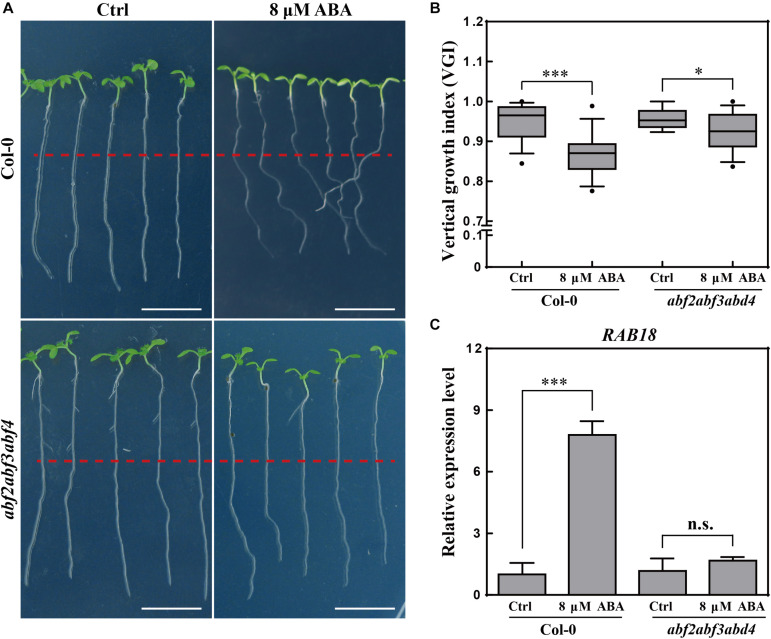
Root VGI of Col-0 and abf2abf3abf4 in response to ABA treatment. (A) Representative images of Col-0 and abf2abf3abf4 seedlings for control and following ABA treatment. 5-day-old seedlings were treated with 8 μM ABA; the photographs were taken 3-day after transfer. White bar represents a scaling bar of 1 cm. n > 30. (B) Root VGI of Col-0 and abf2abf3abf4 seedlings for control and following ABA treatment. Each bar represents the mean of 30 independent measurements ± SE. (C) Relative expression level of RAB18 in roots of Col-0 and abf2abf3abf4 with and without ABA treatment. Each bar represents the mean of 3 biological samples and 3 technical replicates ± SE. * and *** represent p < 0.05 and p < 0.001 respectively.